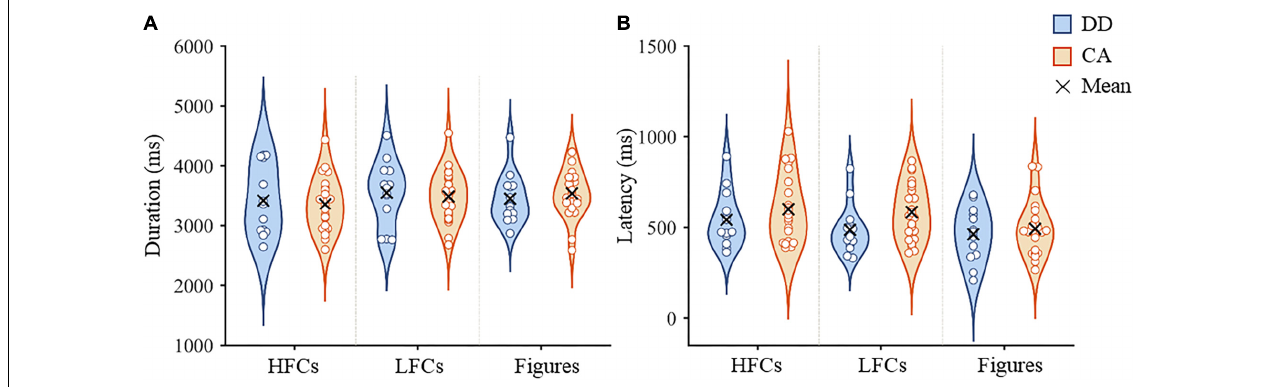
FIGURE 1 | In-scanner performance in the copying and drawing tasks. Violin plots of writing duration (A) and writing latency (B) of dyslexic children and controls during copying HFCs and LFCs and drawing figures. HFCs = high-frequency characters, LFCs = low-frequency characters, DD = developmental dyslexia and CA = chronological-age matched control